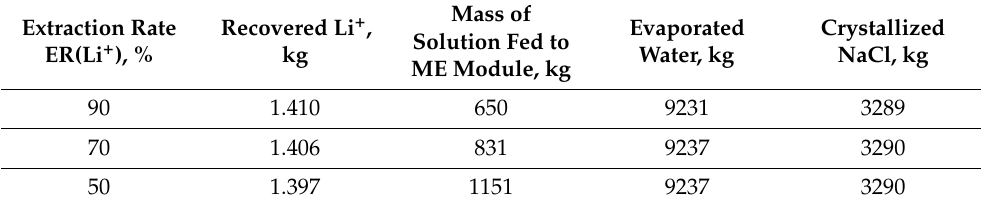
Table 9. Impact of extraction rate on membrane distillation processes (two months of operation).